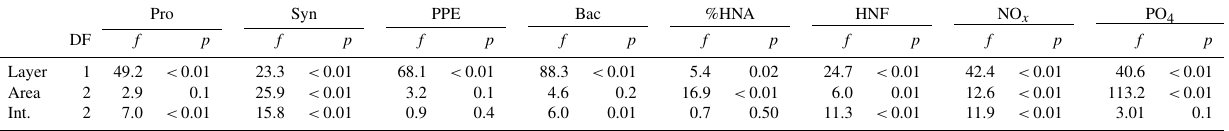
Table 2. Summary table of two-way ANOVA results for parameters analyzed in this study. Row 1 (euphotic layer) tests for significant differences between mean parameter values across different layers of the euphotic layer (Z u or Z l ) on mean parameter values. Row 2 (area) tests for significant differences between mean parameter values across different biogeochemical areas (MA, LDB, and GY). Row 3 (interaction) tests for differences between mean parameter values across both euphotic layer and biogeochemical condition. Relationships for Pro, Bac, HNF, NO x , and PO 4 calculated from depth-integrated abundances; relationships for %HNA calculated from raw values. Pro Syn PPE Bac